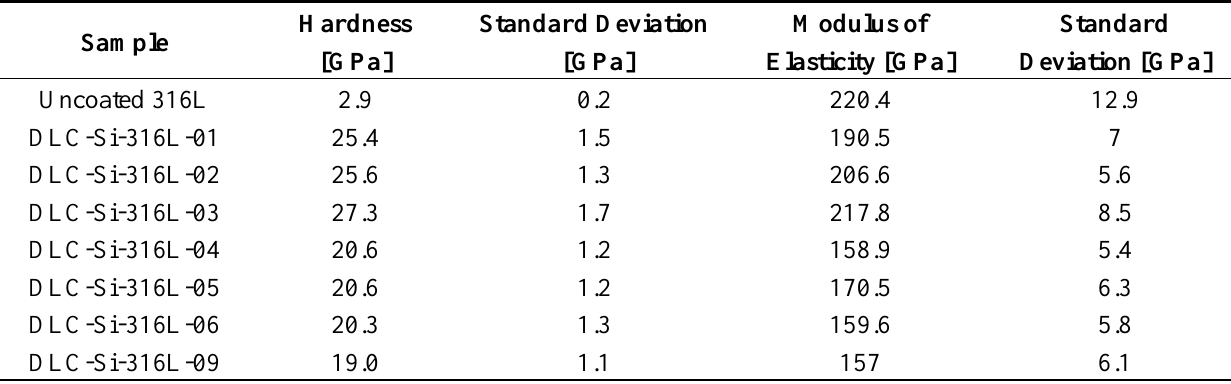
Table 2. Hardness and modulus of elasticity values for DLC coatings DLC-Si-316L-01 to